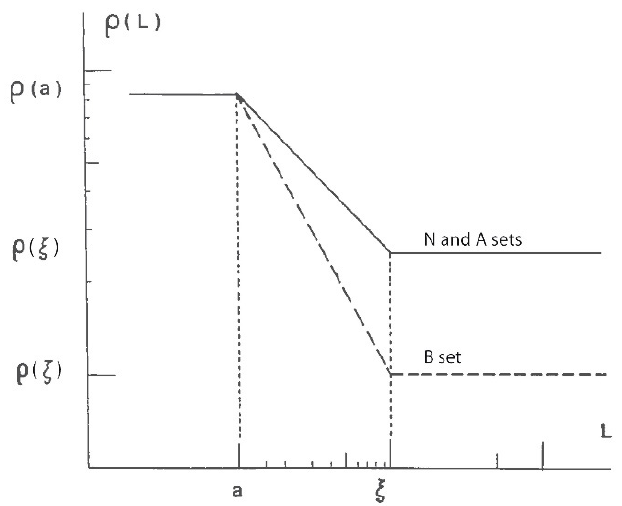
Figure 2. Evolution of the bulk density in a fractal material (issued from [32]).